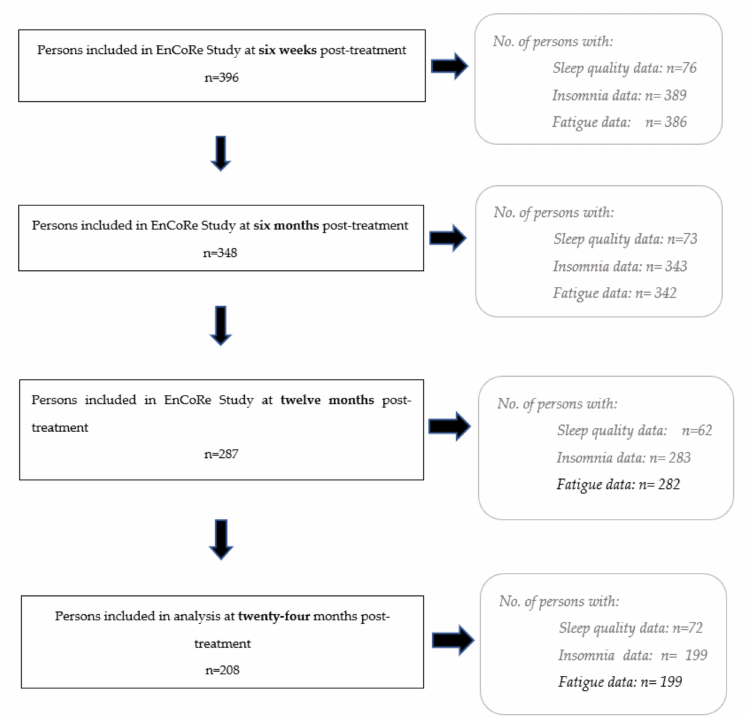
Figure 1. Flow diagram of the respondent frequency ( n ) at each time-point. 1. Data up until July 2018 were used in the present study. The declining number of participants at subsequent time-points is largely due to individuals not having reached the later time-points by July 2018. 2. The